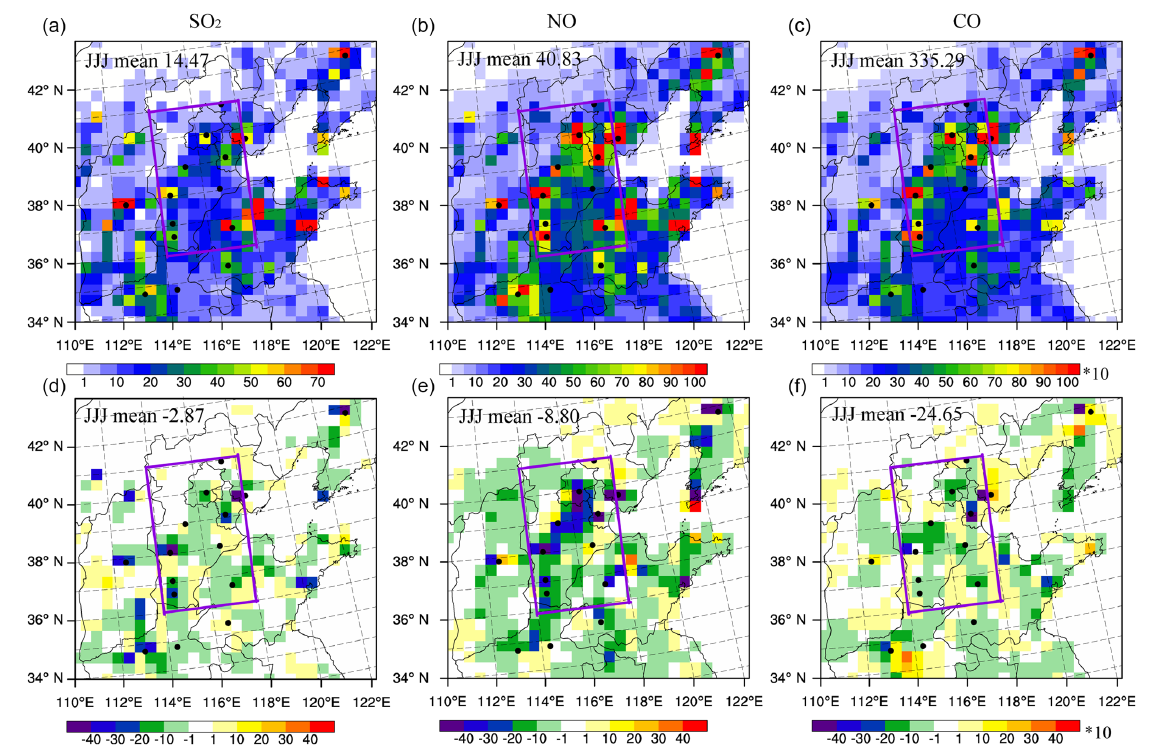
Figure 9. As in Fig. 8 but for SO 2 (a, d) , NO (b, e) , and CO (c, f) . Units for SO 2 , NO, and CO emissions: molkm − 2 h − 1